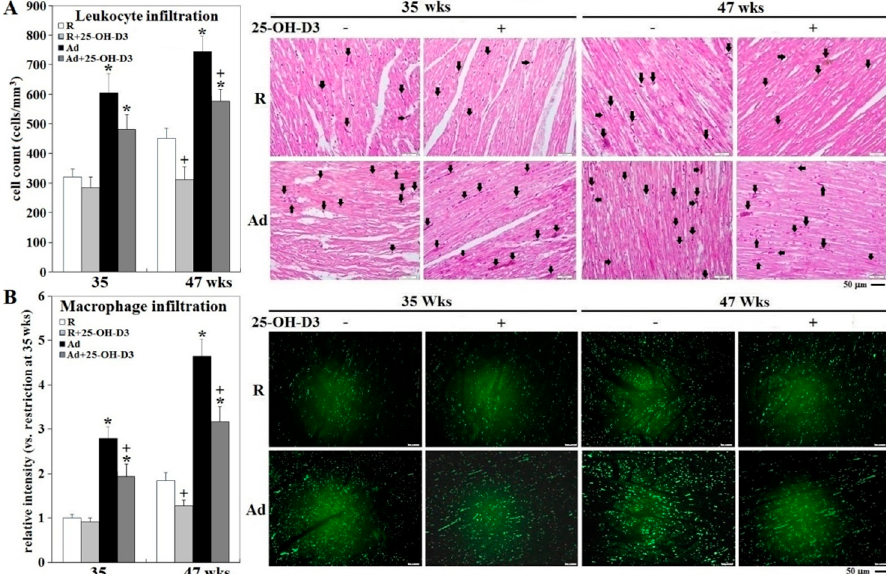
Figure 2. Effects of dietary 25-OH-D 3 supplementation on cardiac leukocyte infiltration of broiler breeder hens provided with restricted or ad libitum feed intake. Three hearts from collections at 35 and 47 wks were used for histological and immunohistochemical studies ( n = 3). Leukocyte infiltration was determined by counts in hematoxylin and eosin (H&E) staining (cells with intense purple color containing dark nuclei indicated by arrows, panel ( A ), and immunohistochemical analysis using a specific antibody against avian macrophages (panel ( B )). Fluorescence results of macrophage infiltration were expressed as ratios relative to R-hens at 35 wks.*; significant difference by Ad-feed intake (vs. corresponding R hens, p < 0.05). +; significant difference by 25-OH-D 3 inclusion (vs. R or Ad hens, p < 0.05). R; restriction, Ad; ad libitum, 25-OH-D 3 : 25-hydroxycholecalciferol.